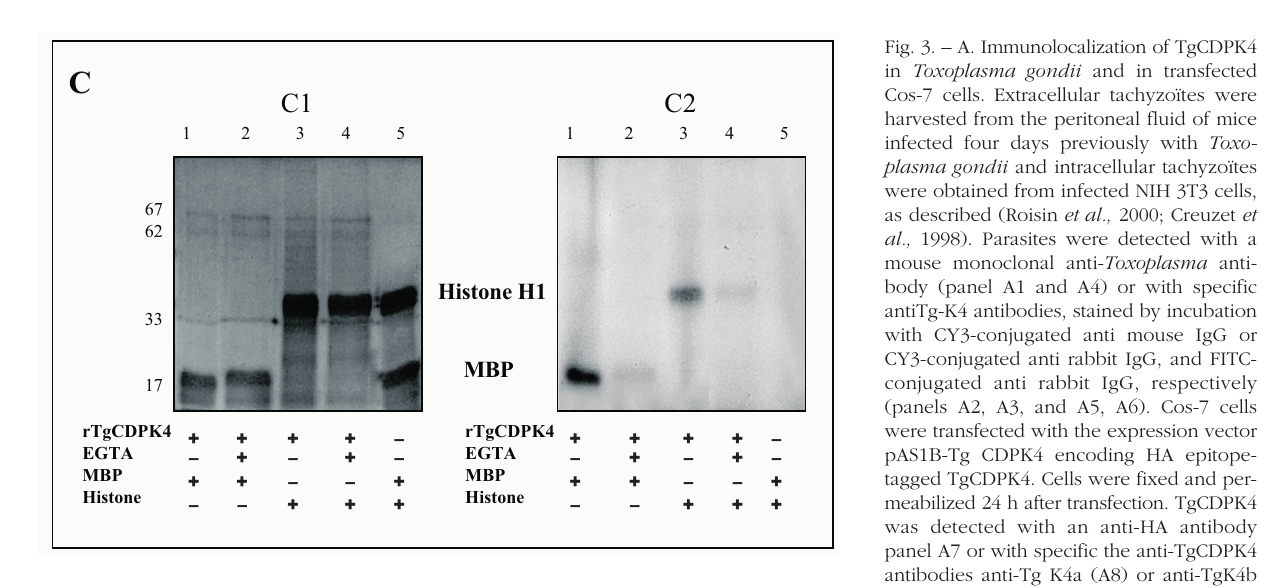
(A9) followed by staining with CY2-conjugated anti-rat IgG (panel A) and FITC-conjugated anti rabbit IgG, respectively (panels B and C). TgCDPK4 was detected in the cytoplasm of Cos-7 cells. No significant background staining was observed with pre- immune sera (data not shown) B. Kinase phosphorylation assay of TgCDPK4: whole lysates or immunoprecipitates of parasite lysates with anti-TGK4b antibody were assayed for kinase activity. Incubation of the tachyzoite extract (lanes 1, 2 and 3), and the immunoprecipitate (lanes 4, 5, 6) with [ γ -32